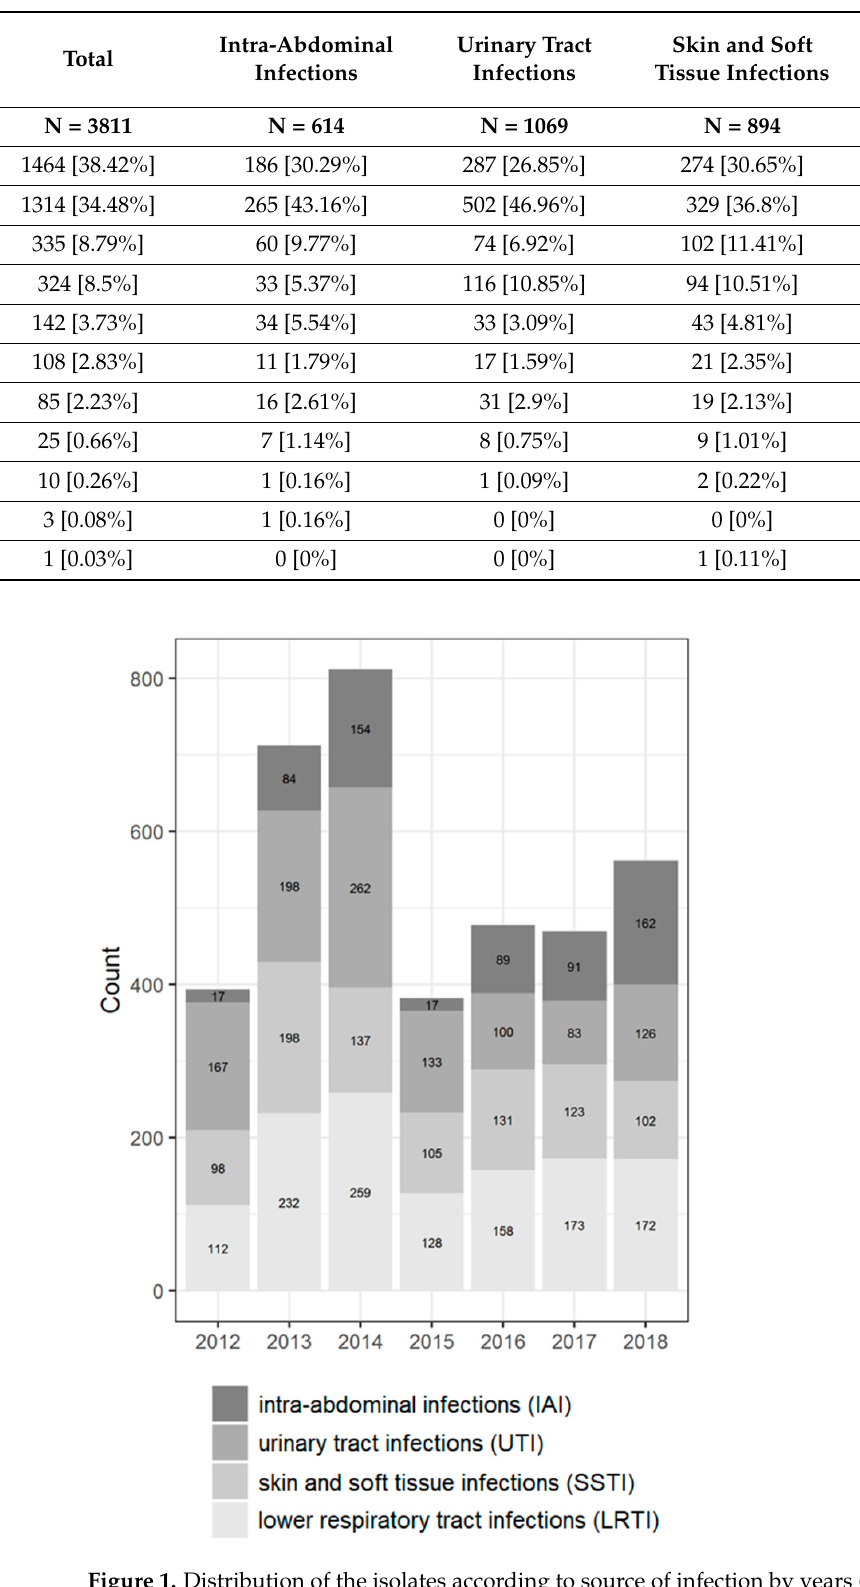
Table 3. Distribution of isolates according to the infection source.